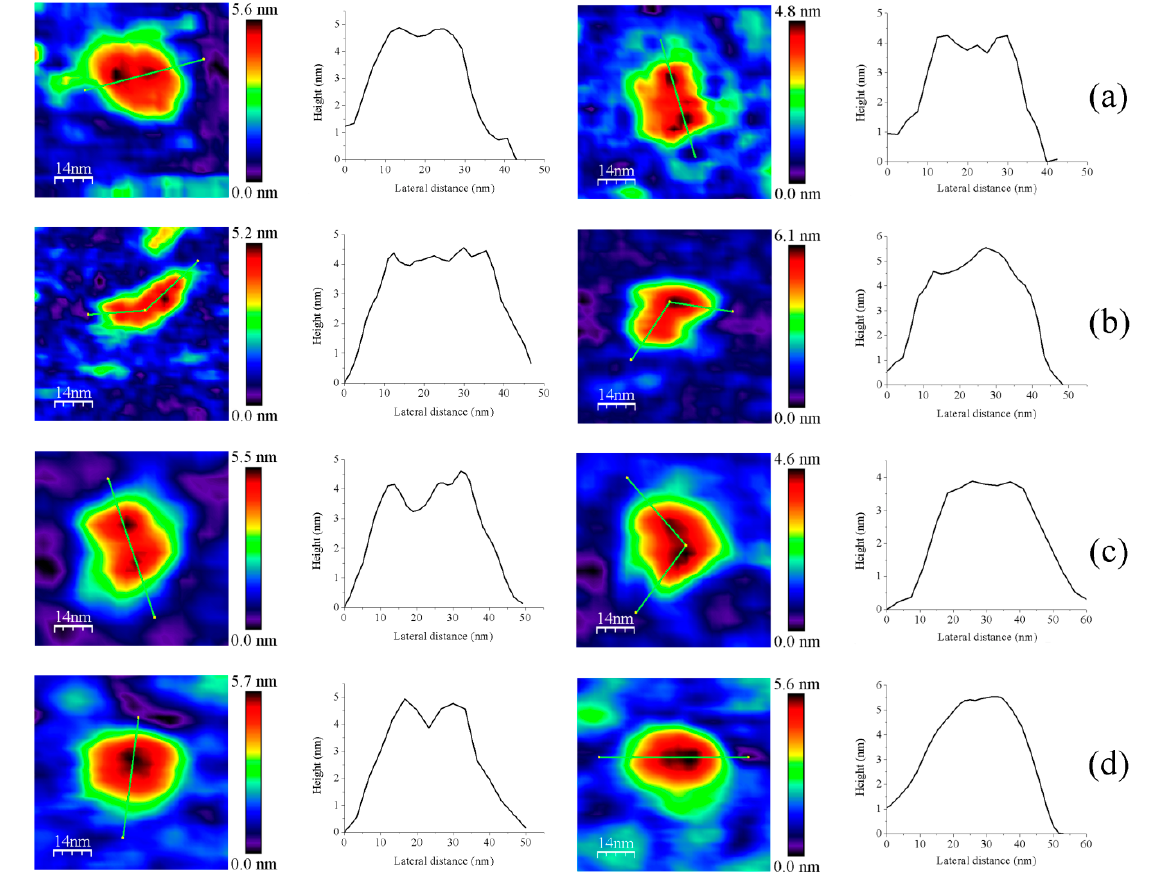
Figure 7. Representative main features as visualized by AFM of 1:2 mixtures of ( a ) GvFFTR with GvFdx1, GvFFTR + GvFdx1; ( b ) GvFFTR with GvTrxm, GvFFTR + GvTrxm; ( c ) GvFFTR_ ∆ tail with GvFdx1, GvFFTR_ ∆ tail + GvFdx1; and ( d ) GvFFTR _ ∆ tail with GvTrxm, GvFFTR_ ∆ tail + GvTrxm. Topography images are shown in 2D (left panels) and height profiles (on their right) correspond to the green lines traced on the 2D images. Two preferred associations are presented for each mixture. Samples were measured in PBS pH 7.0. Scan sizes for all images are 70 nm × 70 nm.